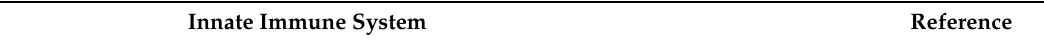
Table 1. Summary of the chicken gut microbiota effect on the innate and adaptive immune system